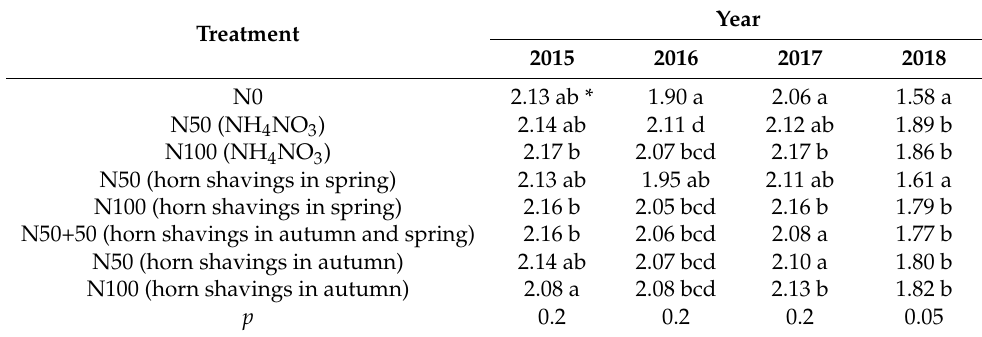
Table 3. Nitrogen content in Ligol apple tree leaves (%).